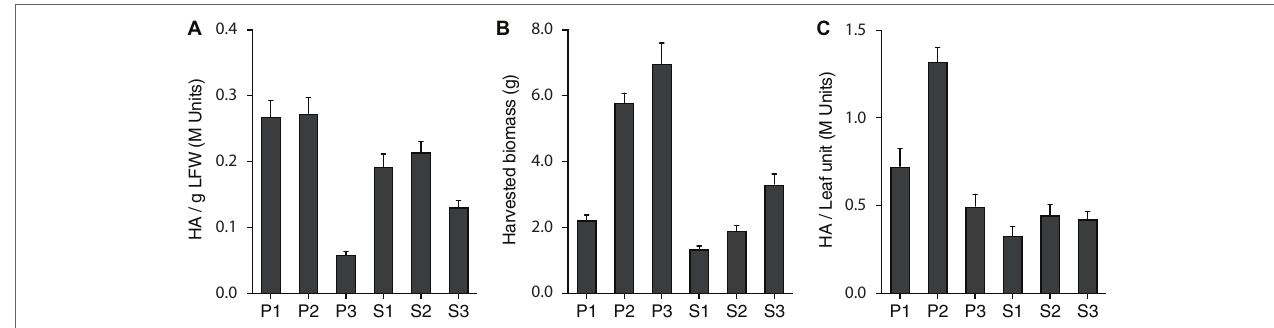
FIGURE 2 | The H1 antigen is not evenly distributed in the plant. H1 hemagglutination activity (A) , harvested leaf biomass following H1 expression (B) , and total H1 yield (C) are here given for the six leaf production units (P1–P3, S1–S3). Data correspond to mean consolidated values calculated with the whole set of data produced for Treatments 1–4 during the PPFD/photoperiod lighting trial. Each bar is the mean of 56 independent (replication) values ± se .